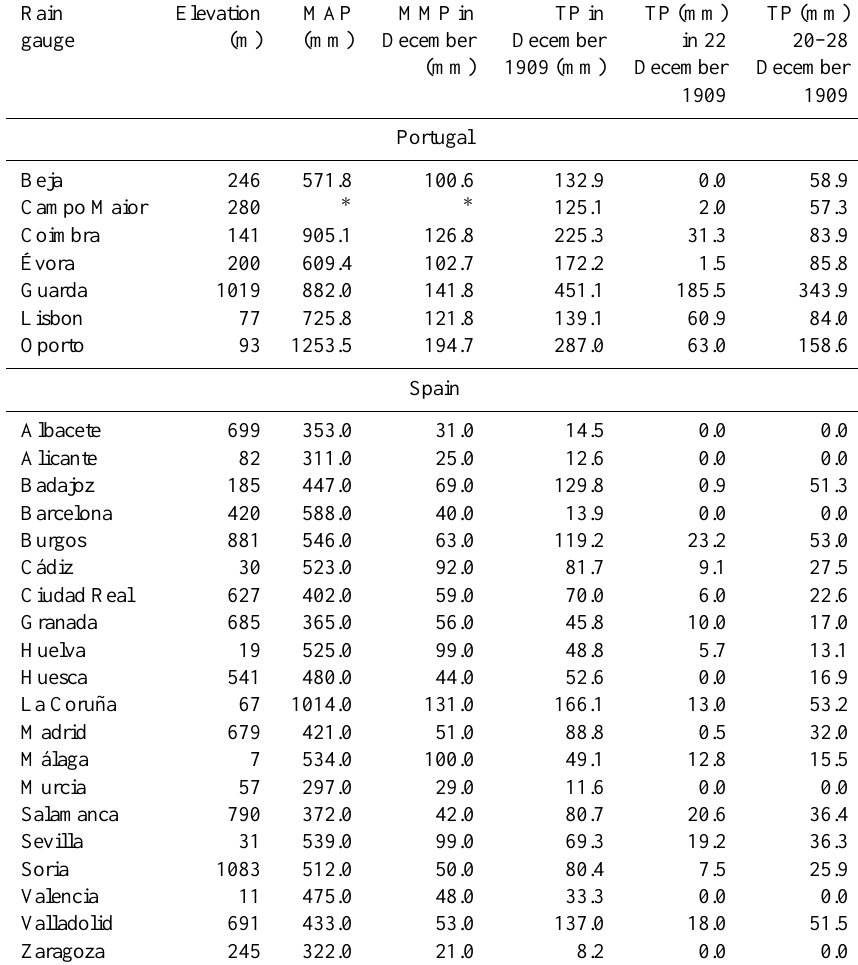
Table 2. Available precipitation stations for December 1909 event in